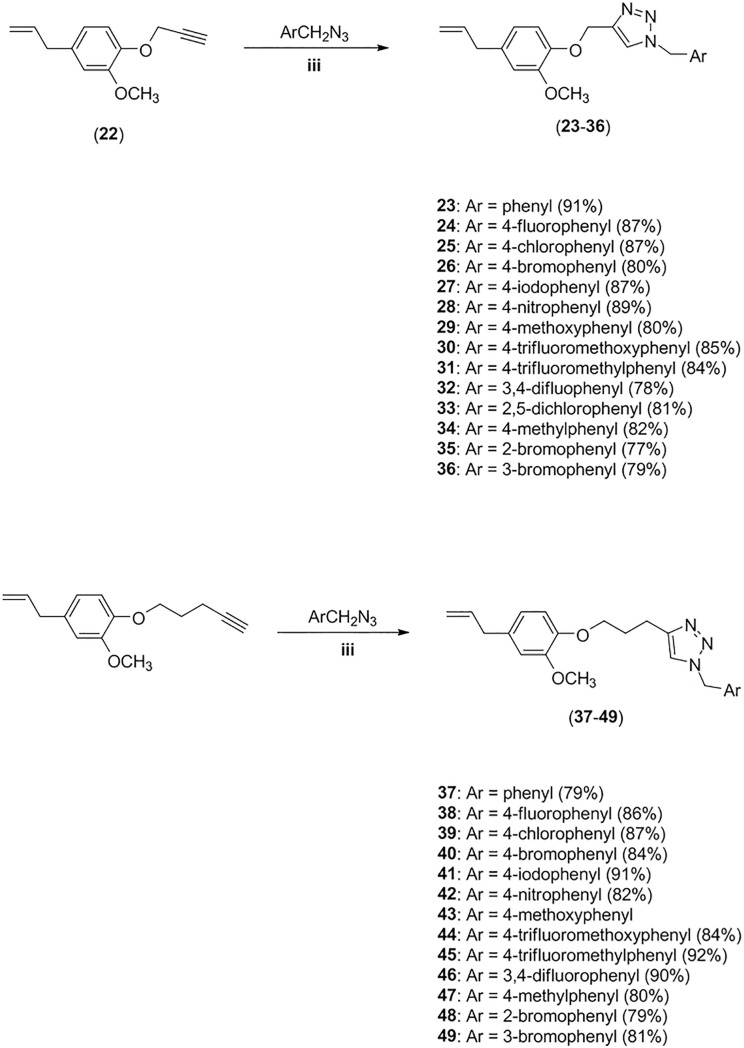
Preparation of eugenol derivatives 23–49.iii) sodium ascorbate (40 mol%), CuSO4·5H2O (20 mol%), EtOH/H2O (1:1 v/v).